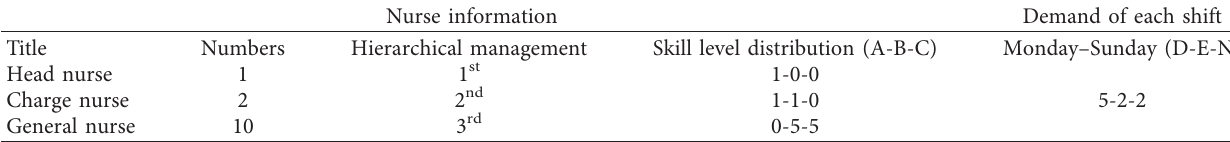
Table 3: Descriptive statistics for nurses and demands in studied local hospital.